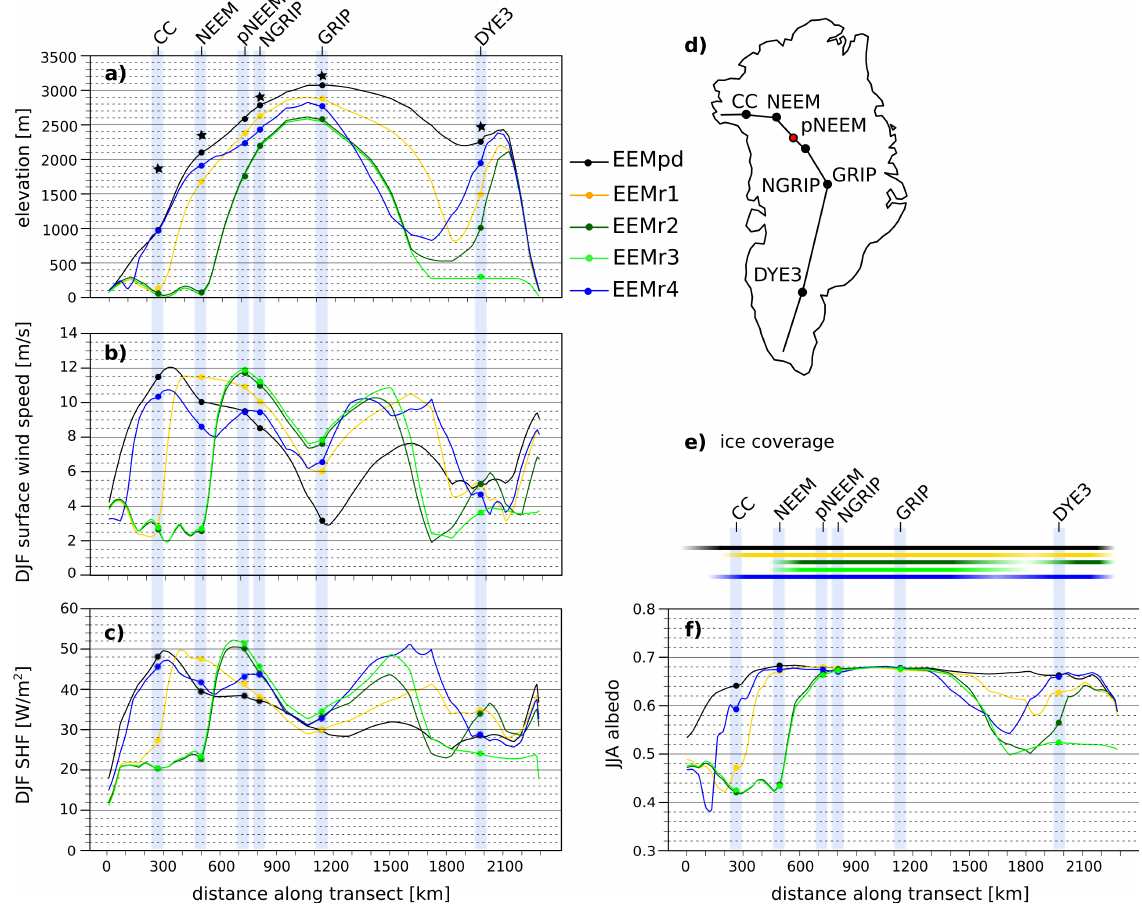
Figure 9. Profiles of (a) surface elevation (m), (b) DJF wind speed (ms − 1 ), (c) DJF SHF (Wm − 2 ), (e) ice coverage, and (f) JJA albedo along the Greenland transect shown in (d) in all Eemian simulations. The transect connects the ice core sites of Camp Century (CC), NEEM, pNEEM, NGRIP, GRIP, and DYE3 from north to south. The black stars in (a) indicate the present-day elevations of the ice core sites in the real world. Bars in (e) show which part of the transect is covered by land ice, whereby partly transparent filling indicates partial ice coverage and opaque filling indicates complete ice